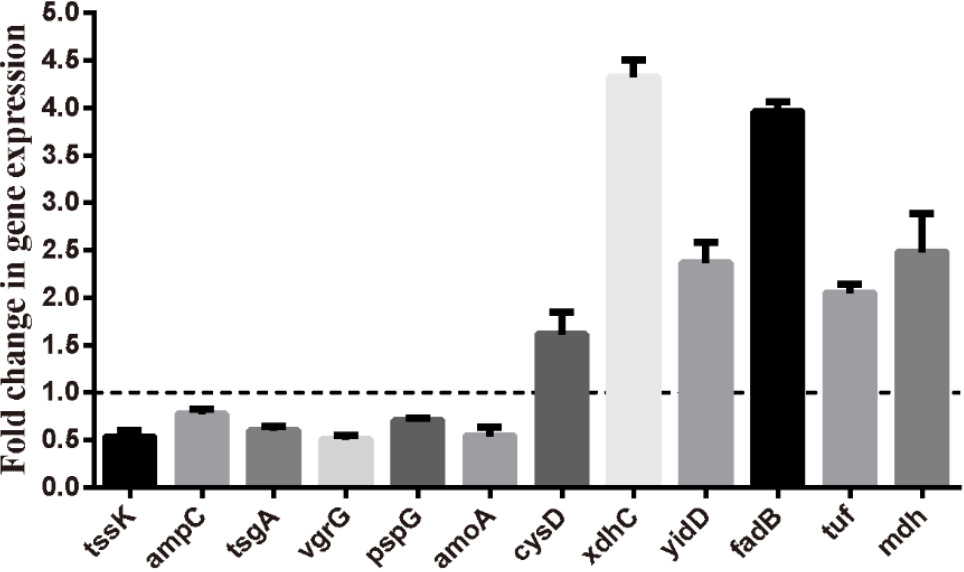
Figure 4. Validation of expression levels of 12 randomly selected genes by qRT-PCR compared with the transcriptome results. Results are represented by mean ± SEM ( n = 3). the transcriptome results. Results are represented by mean ± SEM ( n =